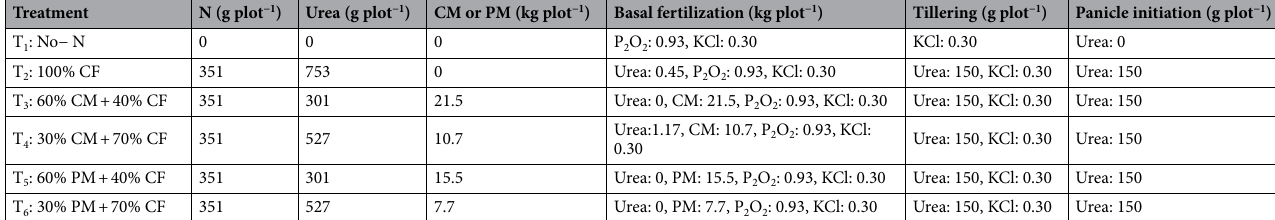
Table 6. Nutrient content and amount nutrient provided of each treatment and application time. N nitrogen, CF chemical fertilizer (urea), CM cattle manure, PM poultry manure, P 2 O 2 superphosphate, KCl potassium